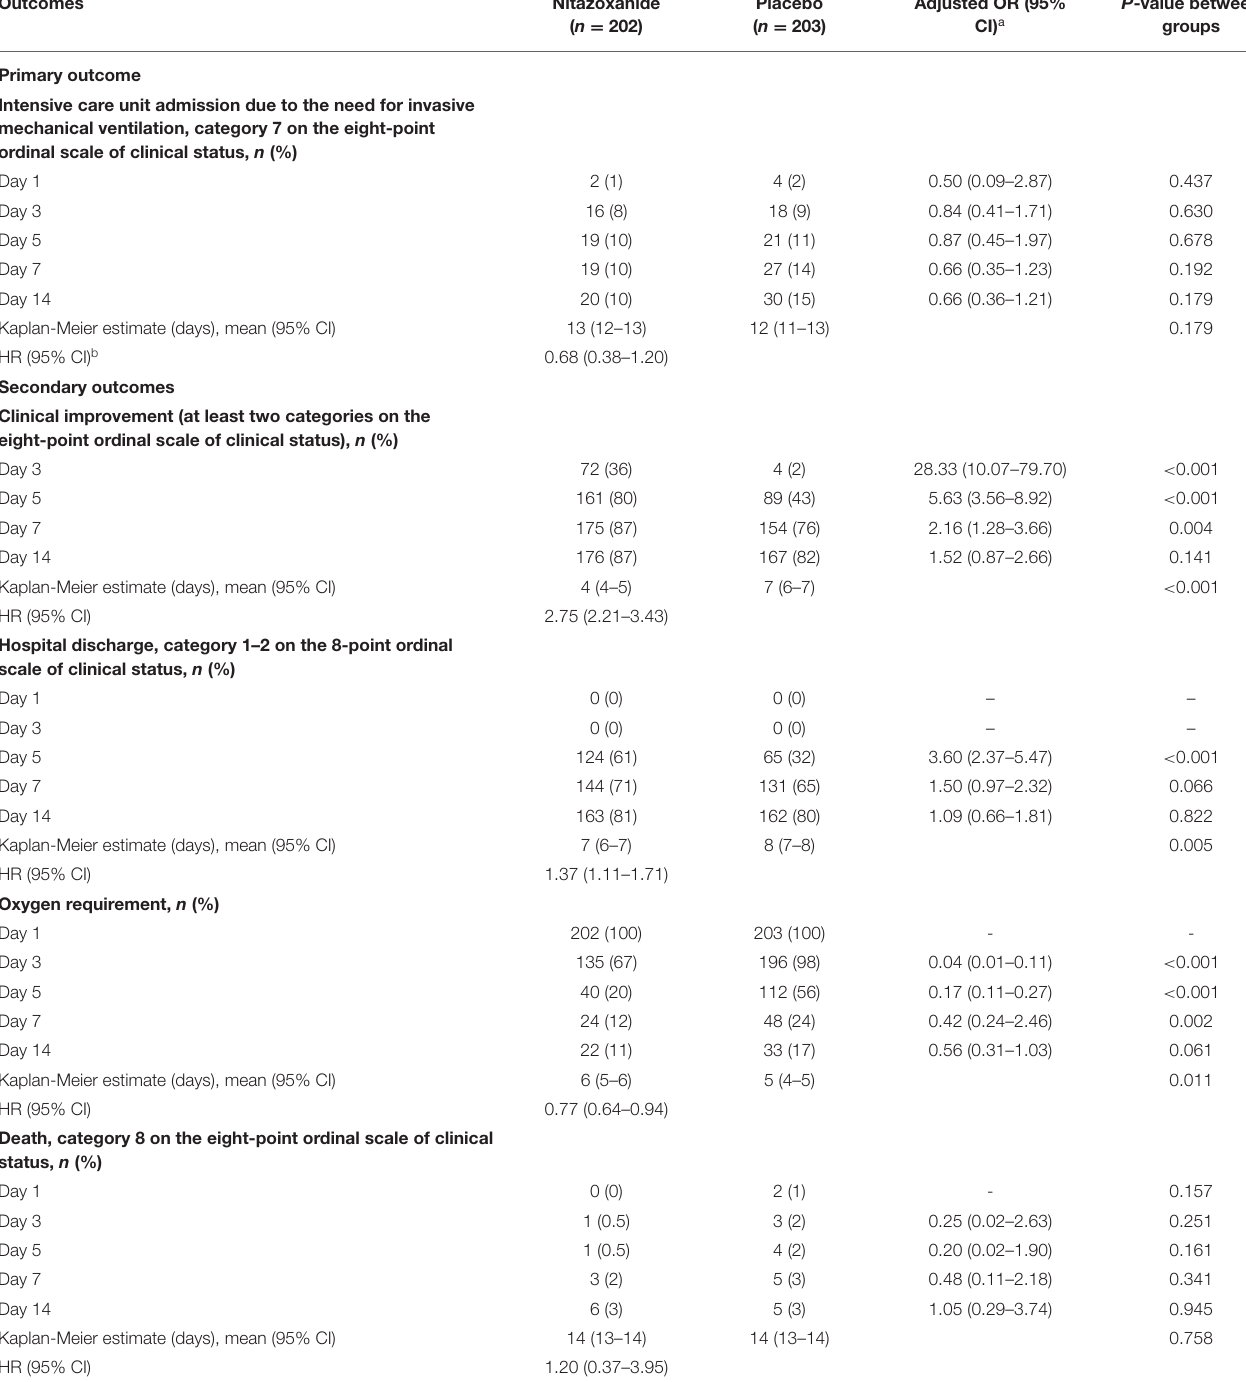
P -value between Placebo Adjusted OR (95% ( n = 202) ( n = 203) CI) a groups